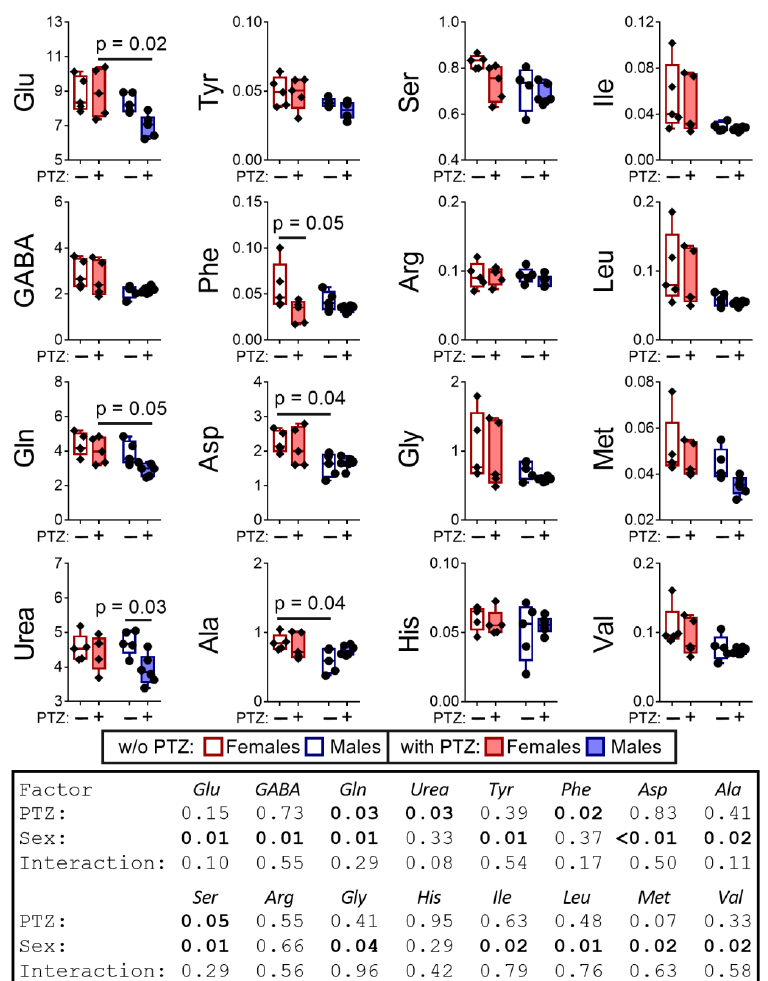
Figure 3. The delayed effect of the PTZ-induced seizures on the levels of amino acids and urea in the cerebral cortex of the male and female rats compared to the control groups. The content of free amino acids and urea is in micromoles per g of tissue. p -values are determined using two-way ANOVA with Tukey ’ s post hoc test (see Section 4).